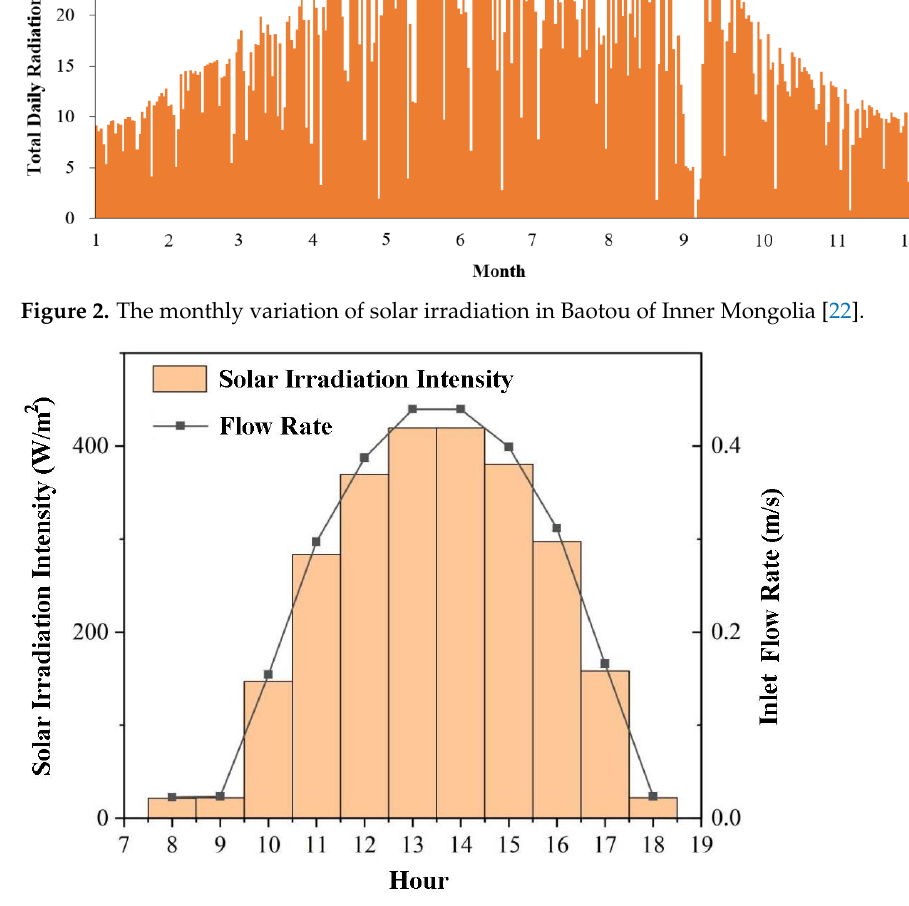
Figure 2. The monthly variation of solar irradiation in Baotou of Inner Mongolia [22].